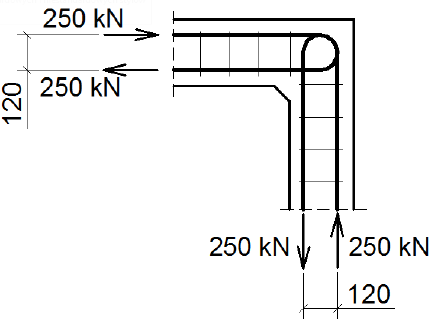
Figure 14. Geometry and main reinforcement for the case of elements with different cross section heights; dimensions in (mm).